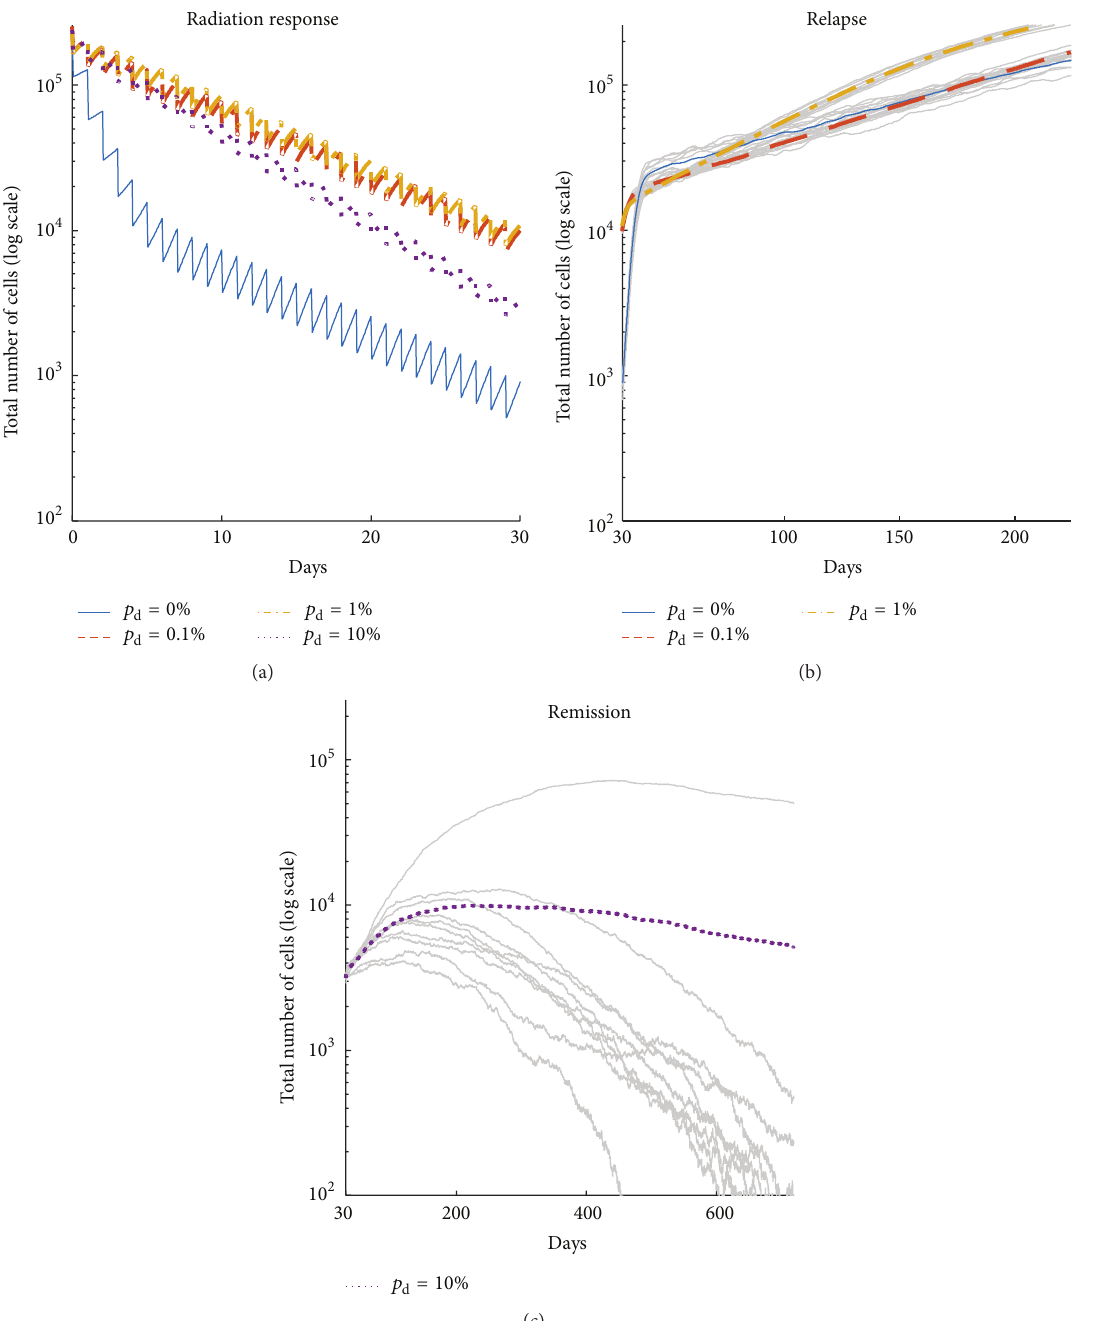
Figure 6: Response to radiotherapy (RT) consisted of 30 × 2 Gy dose applied every day to tumors with about 250,000 initial cell count for different probabilities of plasticity event ( 𝑝 d ). (a) Average radiation response. (b) Regrowth for low 𝑝 d . (c) Remission for 𝑝 d = 10 %. 𝑁 = 10